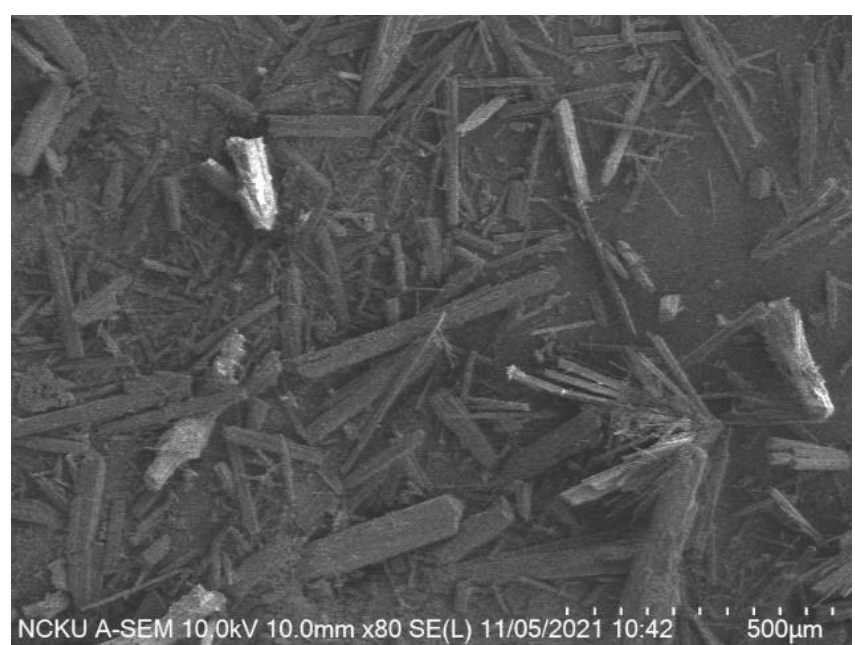
Figure 7. SEM analysis of magnesium carbonate (nesquehonite). Table 3. Whiteness of commercial product and experimental magnesium carbonate.